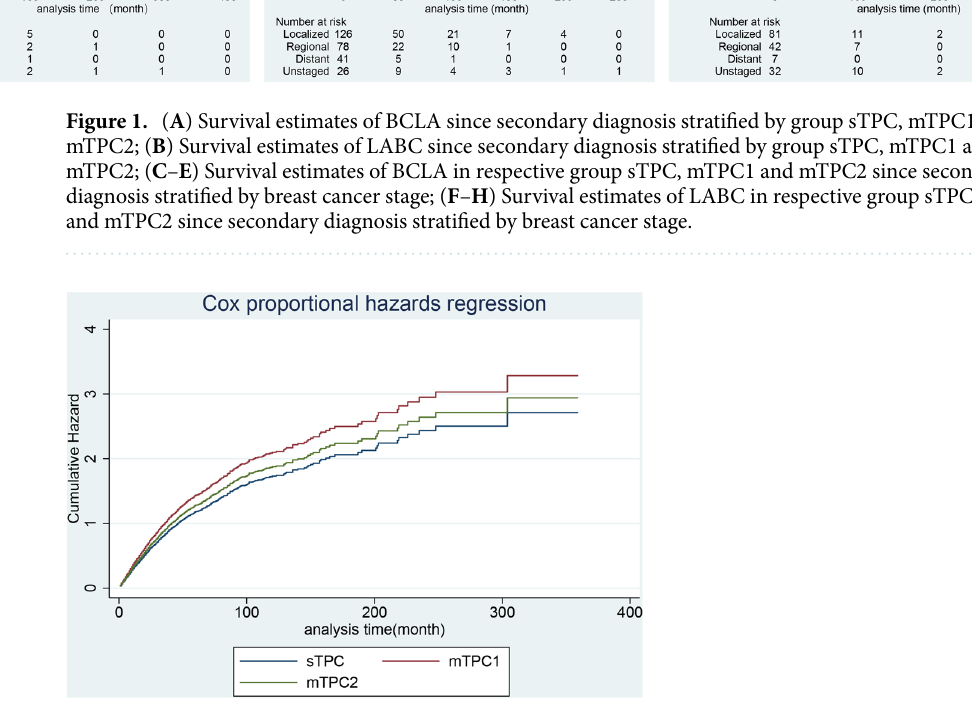
Figure 2. For breast cancer with subsequent lung cancer, adjusted cumulative hazard of all-cause mortality since secondary cancer was classified into group sTPC, mTPC1 and